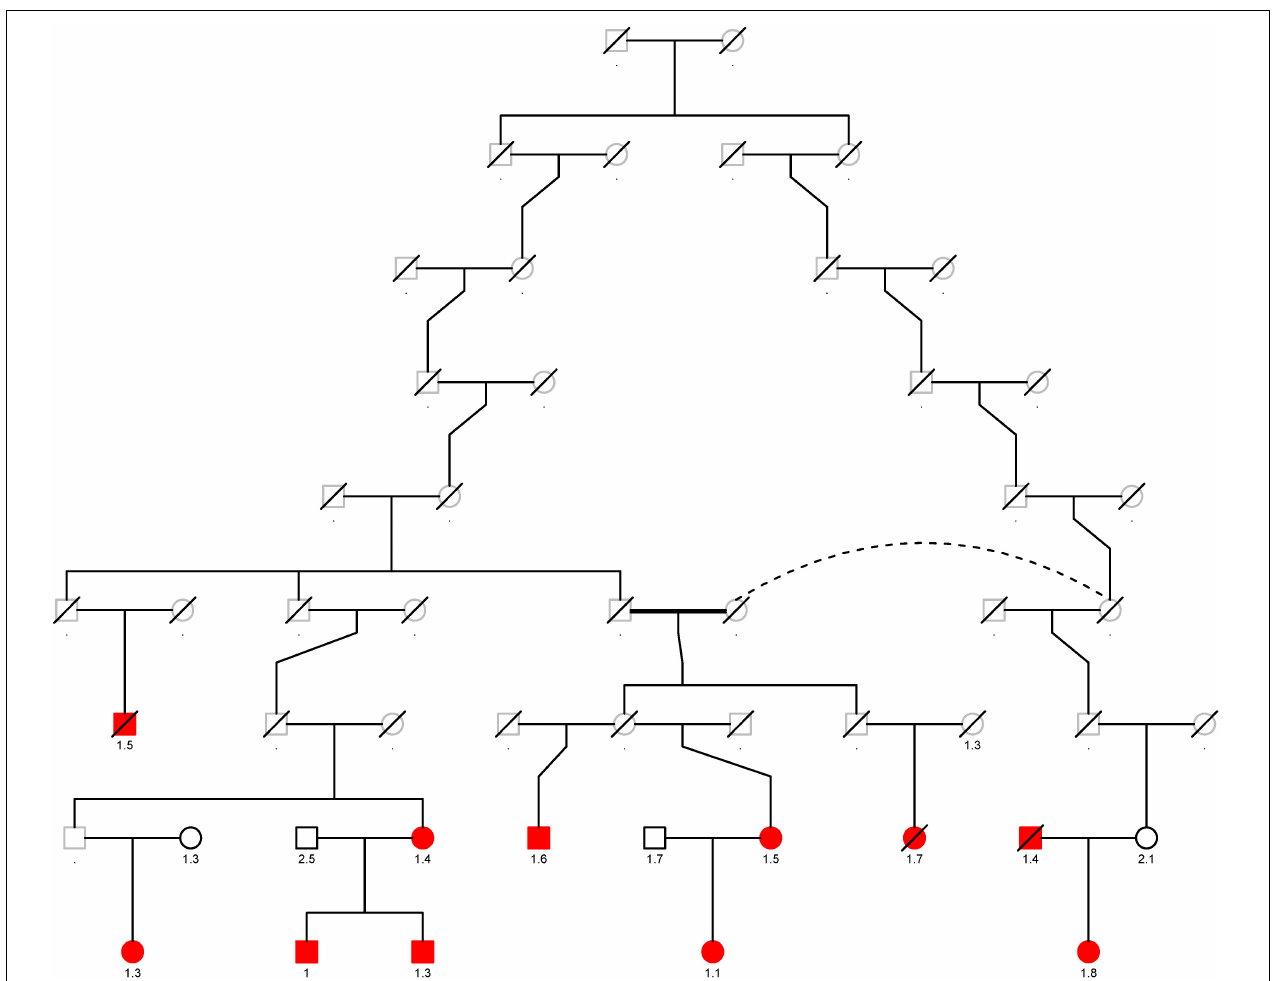
FIGURE 4 | Segregation plot of the rare variants on chromosome 11q22.3 in the ERF study. The carriers of the rare variants located on chromosome 11q22.3 are depicted in red. The T/S ratio is added below the individuals of whom whole-exome sequencing data was available. Squares are males and rounds are females. Deceased individuals are denoted by a line through that specific individual. One person is twice in the pedigree, this is shown with the dotted